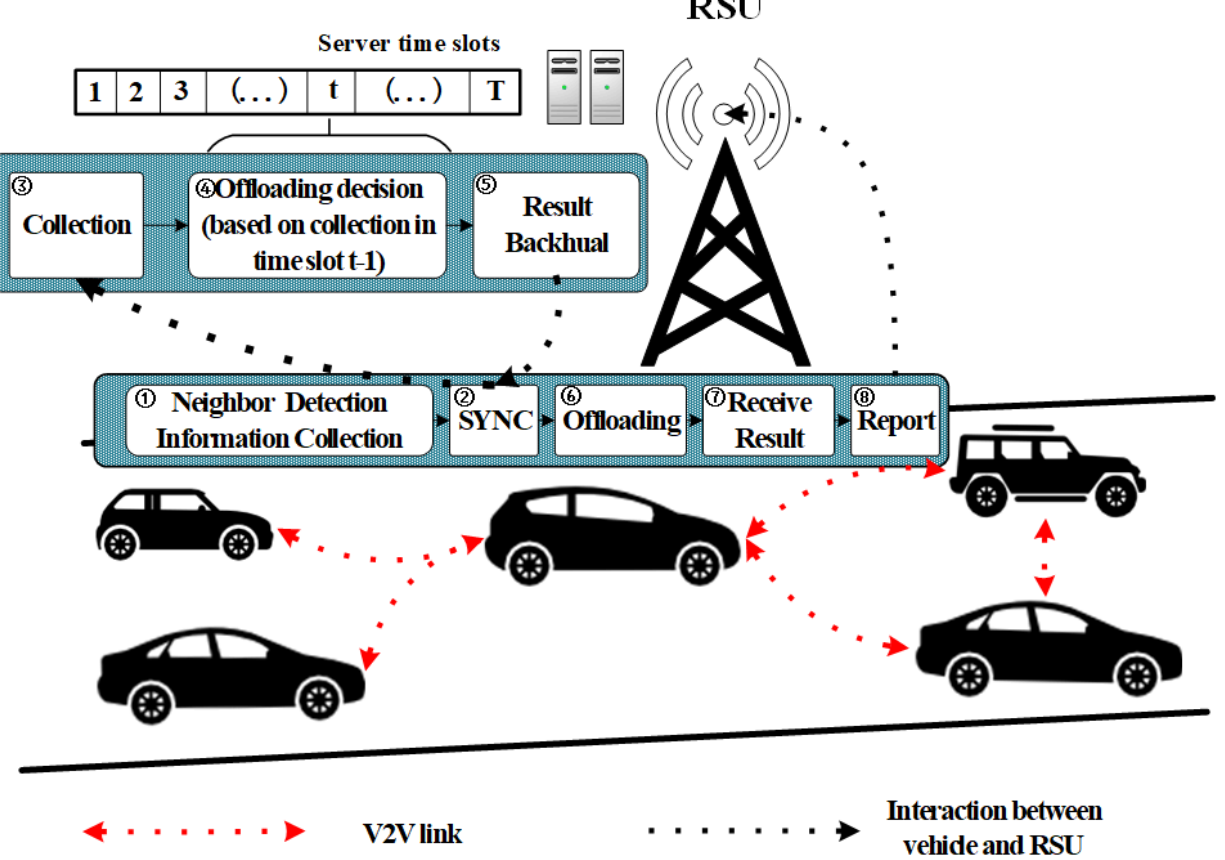
Figure 2. Tasks scheduling procedure in a hybrid VEC-based architecture for cooperative percep- tion.